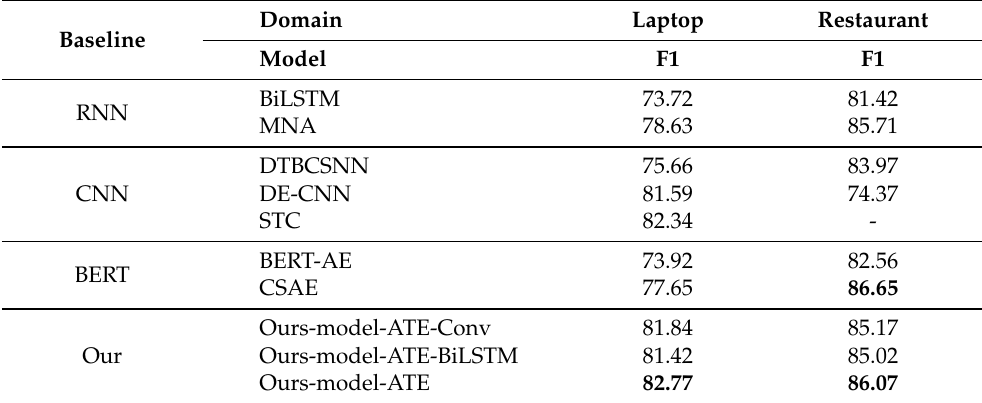
Table 3. Comparing our ATE model with other advanced methods based on F1 scores (%).